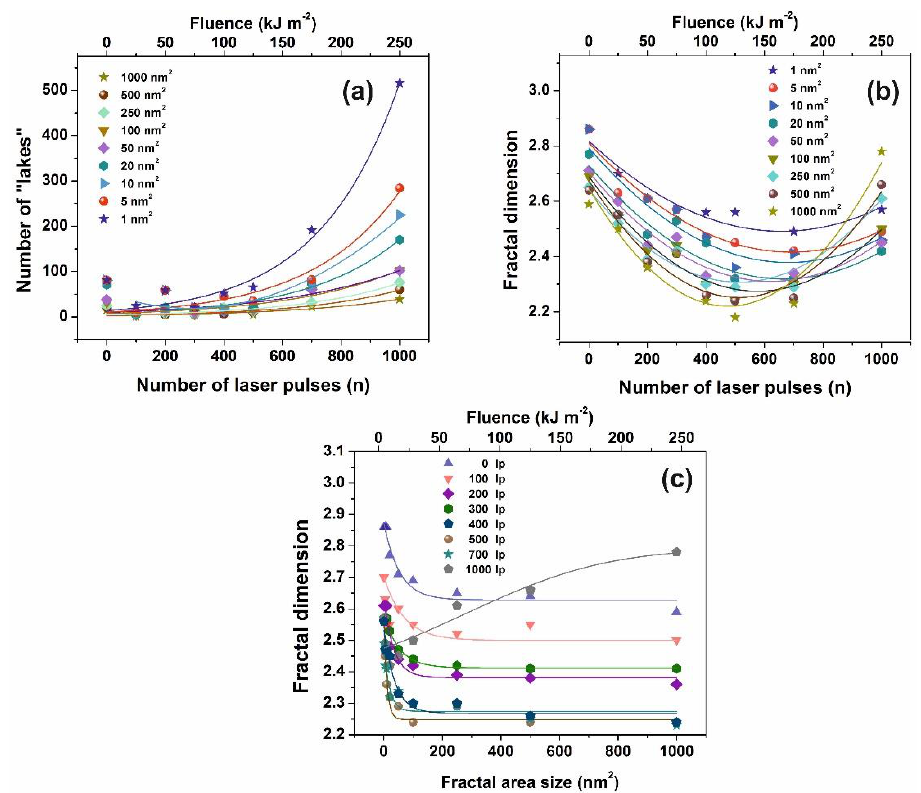
Figure 5. Fractal parameters of polyacrylamide (PAM) at di ff erent laser fluence: ( a ) Number of “lakes” for di ff erent fractal size vs. the number of laser pulses (n) ; ( b ) fractal dimensionality vs. the number of laser pulses (n) for di ff erent fractal size. The concentration of small size nanocavities increases at higher laser fluence; ( c ) fractal dimension vs. fractal size at a di ff erent number of laser pulses (lp).